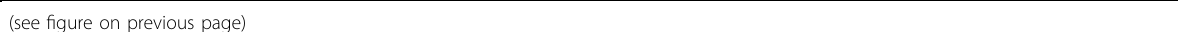
Fig. 4 Expression of HDAC9 in GC cell lines and GC tumor tissues. a HDAC1 – 11 mRNA expression levels in the GC cell lines MKN-45, SGC-7901, BGC-823 and in the normal gastric epithelial cell line GES-1 were measured by qPCR. b The protein expression level of HDAC9 was con fi rmed by western blotting. c Representative HDAC9 IHC image of gastric adenocarcinoma tumor tissues (T) and paired adjacent normal tissues (N) in the tissue microarray. The area in the box was magni fi ed × 200. d The proportional distribution of cases with low, moderate and high HDAC9 expression in GC tissues and the adjacent normal tissues. e Quanti fi cation of HDAC9 expression levels by the IHC score in GC tissues vs. adjacent normal tissues. f The prognostic effect of HDAC9 expression, as determined by www.kmplot.com. *** p < 0.001 versus the normal